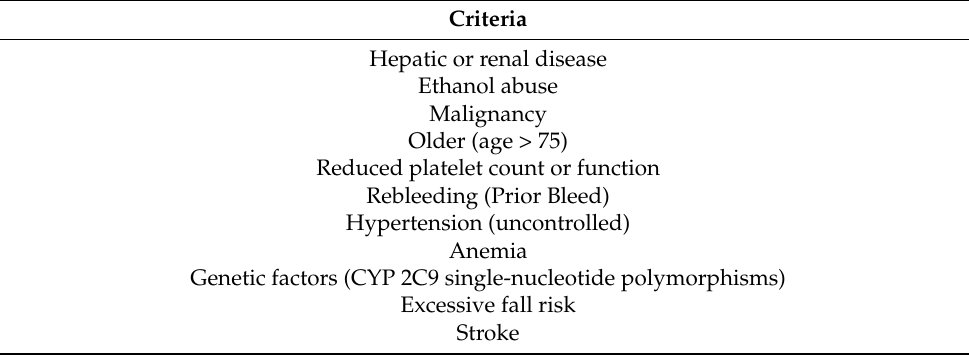
Table 1. Risk factors for bleeding according to the HEMORR 2 HAGES score